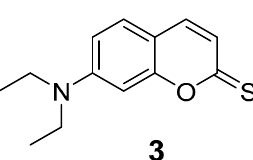
Figure 6. Chemical structure of 7-(diethylamino)-2 H -chromene-2-thione.